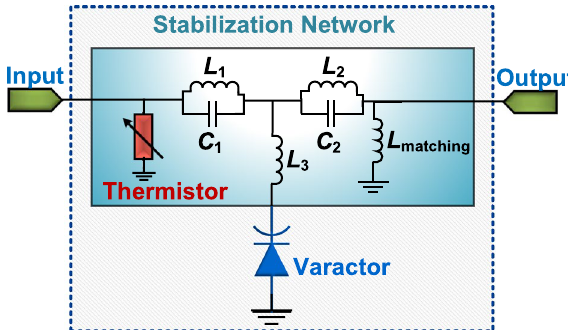
Figure 3. Circuit schematic of the realized SubHT for temperature sensing. The components forming the stabilization network of the built SubHT are shown, including the off-the-shelf thermistor used to activate the unique temperature-sensitive dynamics leveraged during the sensing operation. The components values for the reported prototype are: L 1 = 39 nH, L 2 = 22 nH, L 3 = 22 nH, L matching = 1.8 nH, C 1 = 1.5 pF, C 2 = 1.4 pF, the thermistor’s resistance at ambient temperature is 2.6 (cid:31) and the varactor’s rest capacitance is 1.24